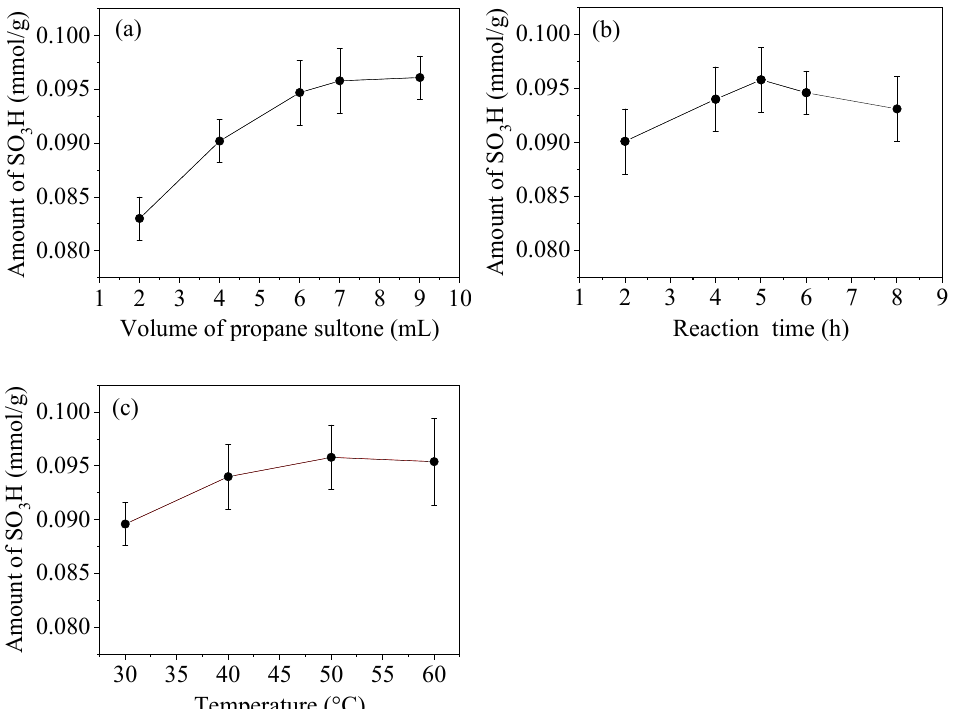
Figure 7. Effects of ( a ) volume of PS, ( b ) reaction time, and ( c ) temperature on the amount of sulfonic acid groups grafted onto SF.